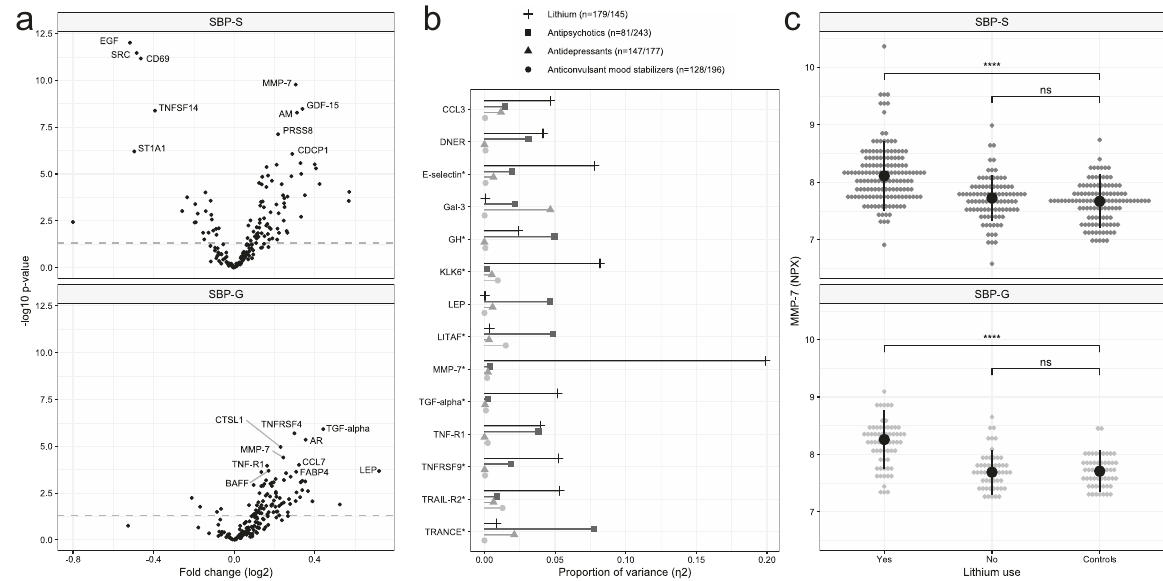
Fig. 1 Overview of case-control results and associations with psychiatric drugs. a Volcano plots summarizing results from case-control analyses ( T -test) in both cohorts. The horizontal line indicates P = 0.05. The top 10 altered proteins in each cohort are labeled. b Proportion of variance ( η 2 from ANOVA models) in protein normalized protein expression (NPX) values explained by each drug category where number of individuals with and without the drug are stated (e.g., 179 individuals were treated with lithium, 145 were not). Proteins with a Bonferroni- adjusted P -value < 0.2 are shown. *Bonferroni-adjusted P < 0.05. c Dot plot showing NPX-values of MMP-7 for each individual strati fi ed by lithium use. P -values from T -tests. **** P < 0.0001, ns not signi fi cant. AM pro-adrenomedullin, AR amphiregulin, BAFF tumor necrosis factor ligand superfamily member 13B, CCL3 C-C motif chemokine 3, CCL7 C-C motif chemokine 7, CD69 early activation antigen CD69, CDCP1 CUB domain-containing protein 1, CTSL1 procathepsin L, DNER Delta and Notch-like epidermal growth factor-related receptor, EGF pro-epidermal growth factor, FABP4 fatty acid-binding protein, adipocyte, Gal-3 Galectin-3, GDF-15 growth/differentiation factor 15, GH somatotropin, KLK6 kallikrein-6, LEP Leptin, LITAF lipopolysaccharide-induced tumor necrosis factor-alpha factor, MMP-7 matrilysin, PRSS8 prostasin, SRC proto- oncogene tyrosine-protein kinase Src, ST1A1 sulfotransferase 1A1, TGF - alpha protransforming growth factor alpha, TNFRSF9 tumor necrosis factor receptor superfamily member 9, TNF-R1 tumor necrosis factor receptor superfamily member 1A, TNFRSF4 tumor necrosis factor receptor superfamily member 4, TNFSF14 tumor necrosis factor ligand superfamily member 14, TRAIL-R2 tumor necrosis factor receptor superfamily member 10B, TRANCE tumor necrosis factor ligand superfamily member 11, SBP-S/G St. Göran bipolar project Stockholm/